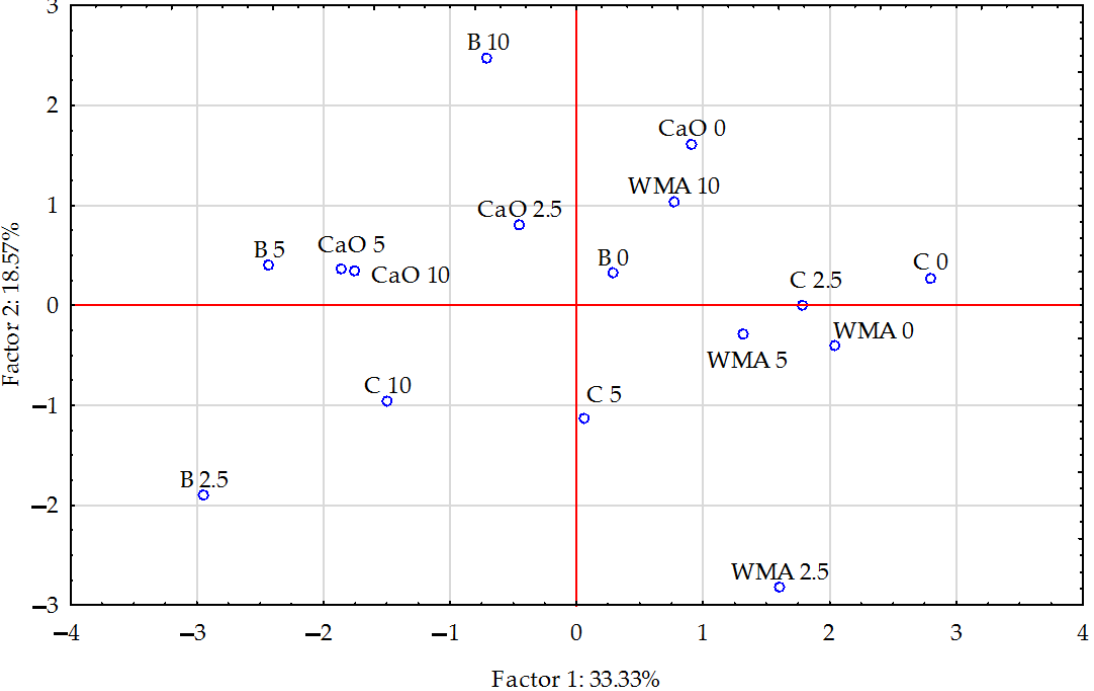
Figure 2. The effect of the amendments on the content of trace elements in the soil illustrated with a PCA analysis. Key: points show the samples with elements (WMA—without material amendments, C—compost, B—bentonite, CaO—calcium oxide; 0—0 cm 3 (control), 2.5—2.5 cm 3 , 5—5 cm 3 , and 10—10 cm 3 petrol per kg of soil.